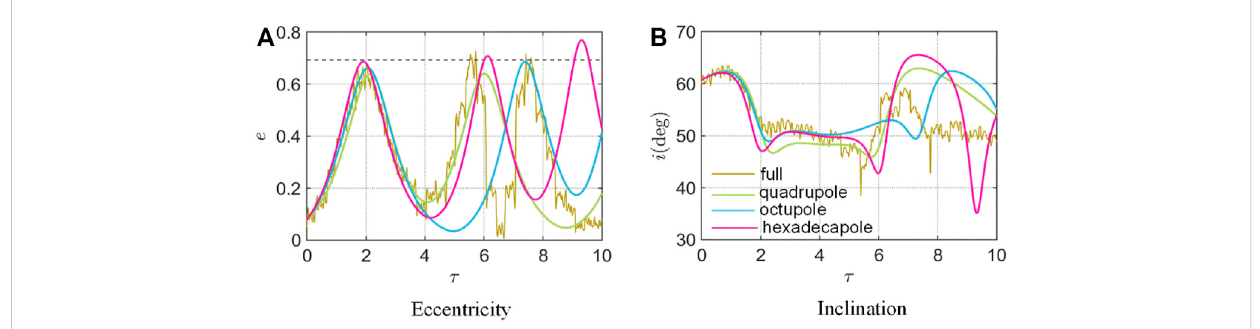
FIGURE 6 Long-term orbital evolution for a (cid:2) 9 . 0km over 10 scaled time with the other conditions set the same as Figure 4. The panels (A,B) show the temporal evolution of the eccentricity and inclination, respectively.